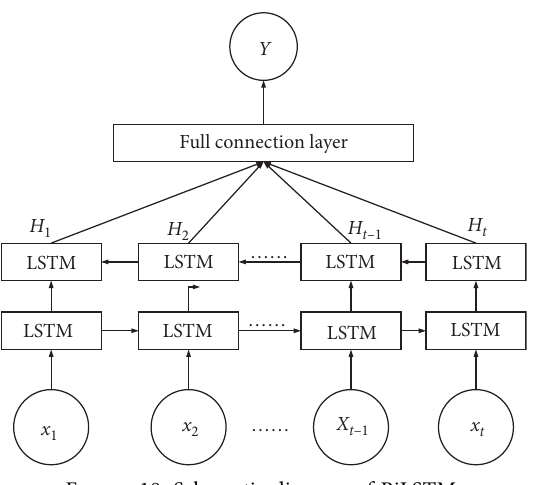
Figure 18: Schematic diagram of BiLSTM.